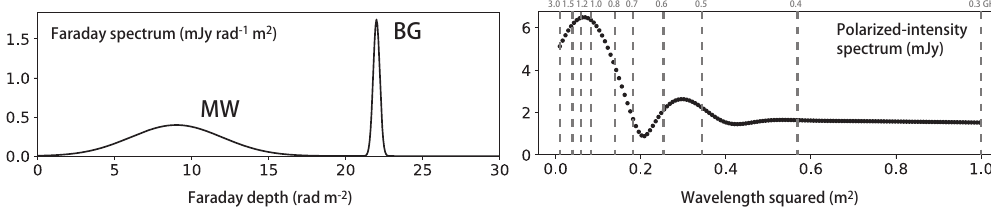
Figure 4. ( Left ) Faraday spectrum. ( Right ) Polarized intensity